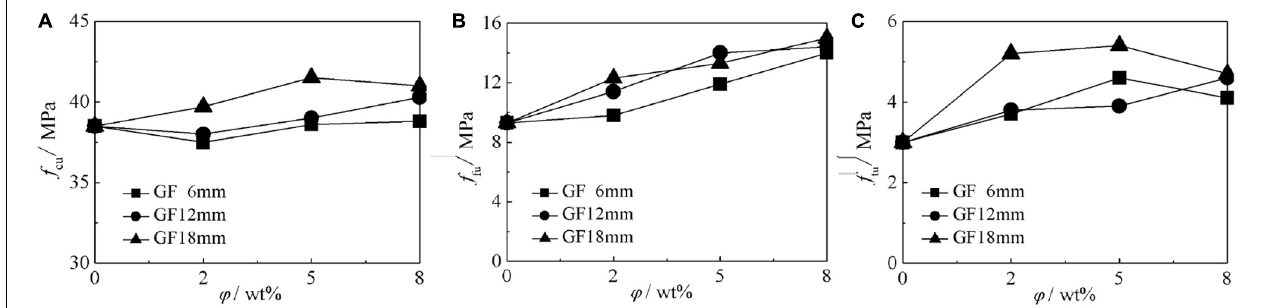
FIGURE 2 | Strength of fine-grained reinforced concrete varies with the contents of AR-glass fiber. (A) Compression strength, (B) bending strength, and (C) splitting tensile strength.